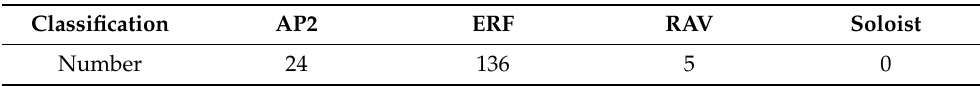
Figure 1. The distribution of AP2/ERF genes on chromosomes in rice. Table 1. Classification and quantity of AP2/ERF transcription factors in rice.